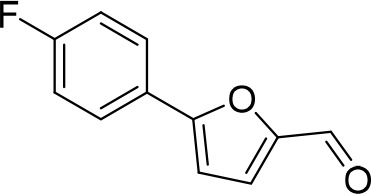
5-(4-Fluorophenyl)furan-2-carbaldehyde (D1).